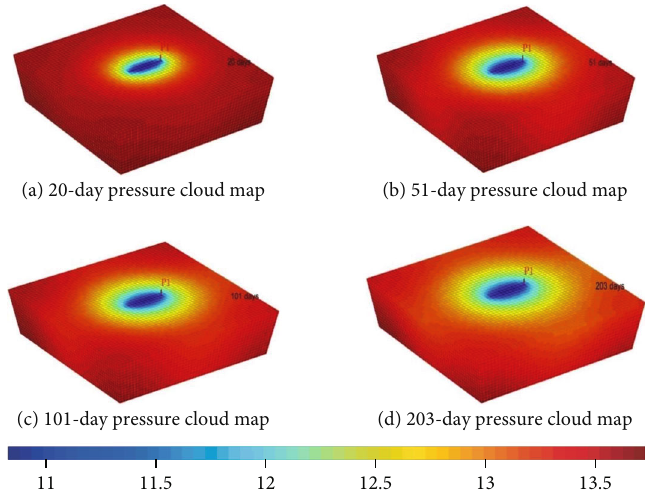
Figure 4: Pressure cloud diagram of horizontal wells in homogeneous reservoirs at di ff erent production times.